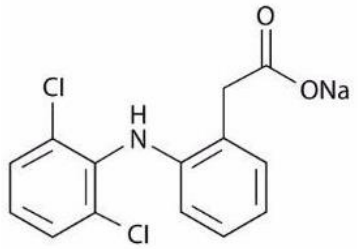
Figure 1. Structure of diclofenac sodium molecule.